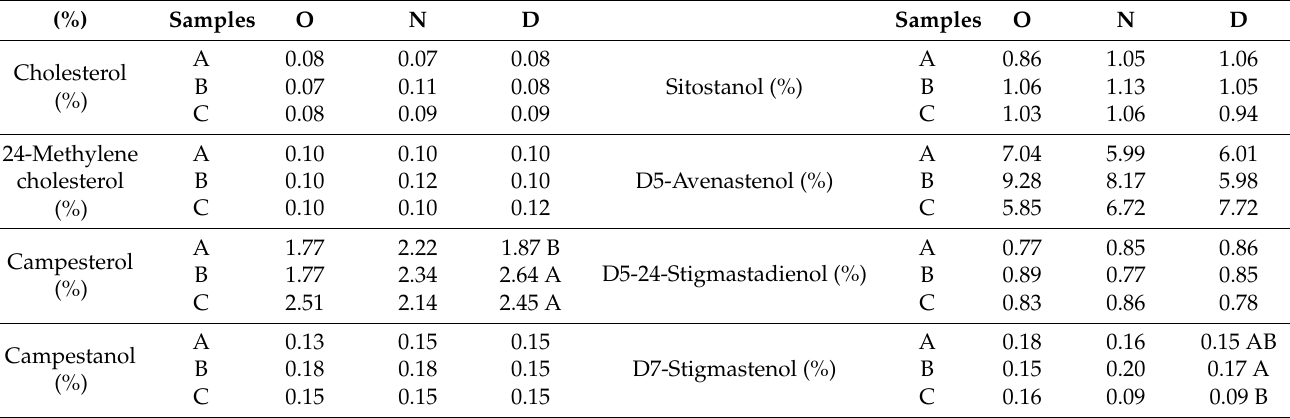
Table 3. Sterol composition of olive oils produced in the three locations (A, B, and C) at October (O), November (N) and December